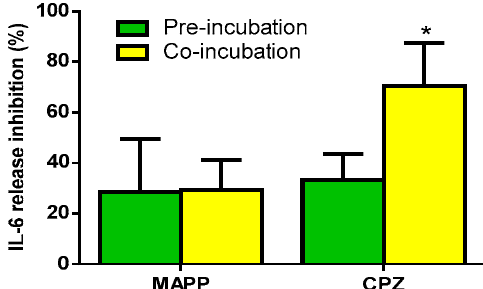
Figure 5. IL-6 release promoted by LDL( − ) in pre-incubation or co-incubation with MAPP and CPZ . Monocytes were incubated with LDL( − ) (60 mg apoB/L), which was pre-incubated (green bars) or co-incubated (yellow bars) with the inhibitors MAPP and CPZ, both at 10 µM. After 20 h of incubation, cytokine release was measured by ELISA. Results are expressed as % of inhibition versus LDL( − ) in the absence of an inhibitor, mean ± SD ( n = 5), * vs. pre-incubation conditions, p < 0.05.